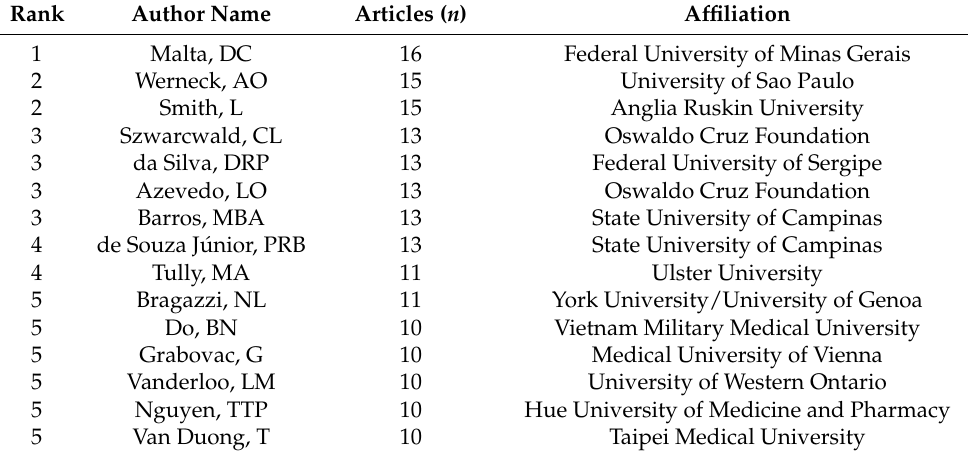
Table 2. Most productive authors on physical activity and coronavirus disease